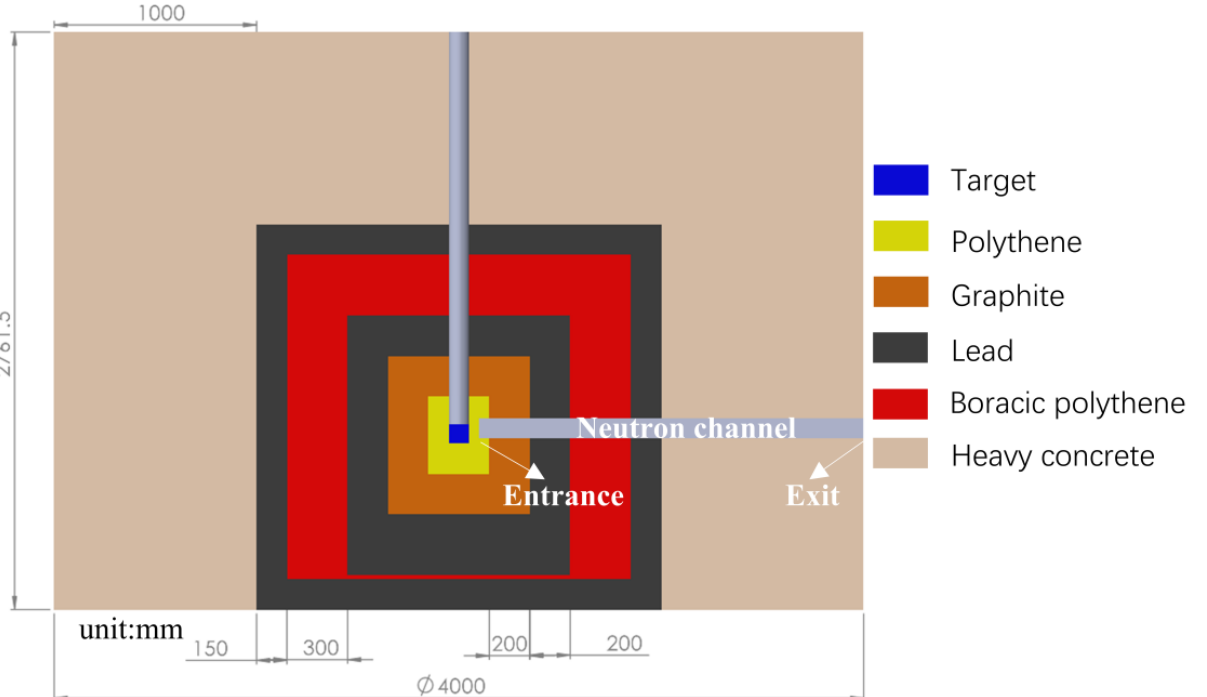
Figure 7. Neutron and photon dose map for TMR. 3.3. Tailoring the Ratio between the Bremsstrahlung Photons and the Emitted Neutrons